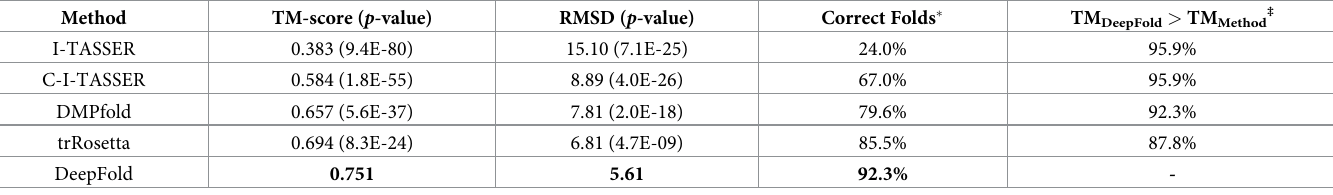
Table 1. Summary of the structure modeling results by DeepFold and the control methods on the 221 test proteins. The p -values were calculated between DeepFold and the control methods using paired, two-sided Student’s